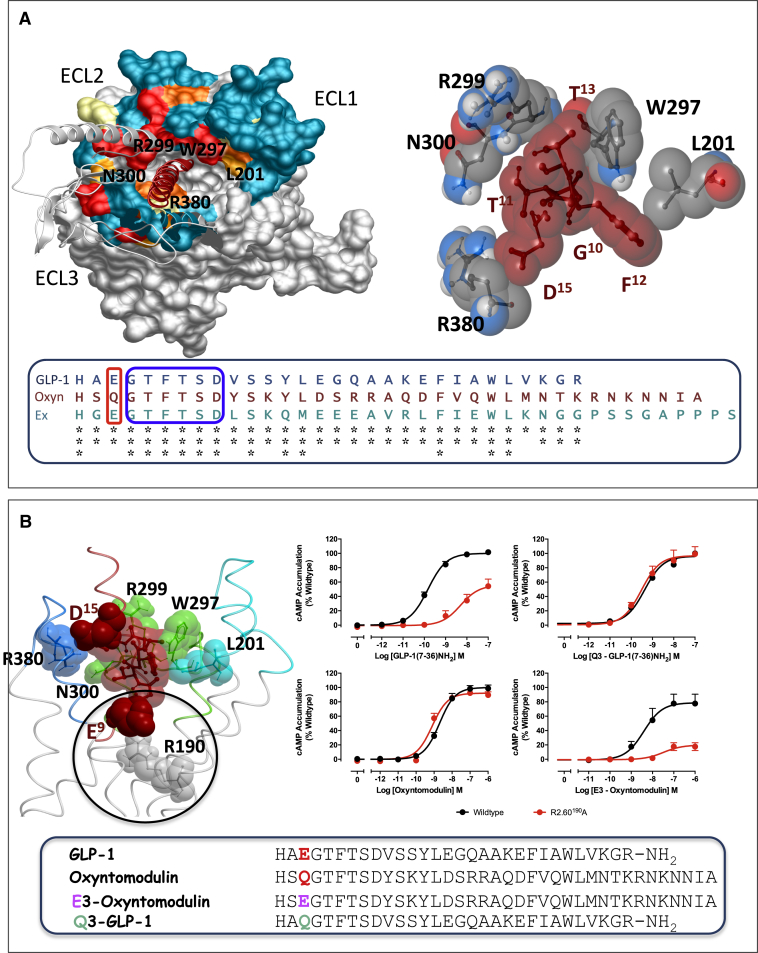
Direct Interactions of the GLP-1R ECL Residues and TM Bundle with GLP-1 Predicted from Molecular Modeling, Related to Figures 1 and 2(A) Top left: Molecular model of GLP-1 (maroon) docked to the GLP-1R with key ECL residues labeled that line the entry to a deep cavity where the N terminus of GLP-1 is predicted to bind. Colors are the heatmaps from binding studies of GLP-1 from Figure 2. Top right: Close up of the peptide and ECL GLP-1R side chains that form direct interactions. Bottom: Sequence alignment of GLP-1, oxyntomodulin (Oxyn) and exendin-4 (Ex) highlighting the absolute sequence conservation within the region of the GLP-1 peptide (blue box) that is predicted to interact with the ECL residues, L201, W297, R299, N300, and R380 in the molecular model. Within the extreme N terminus of the three peptides, only position 3 (position 9 in the unprocessed GLP-1 peptide) differ significantly between GLP-1 and exendin (E) in comparison to oxyntomodulin (Q), as highlight by the red box.(B) E9 of GLP-1 (position 3) is predicted to interact with R1902.60 within the TM bundle cavity. Q3 of oxyntomodulin would not be predicted to form this sat bridge. In support of this, mutation of R190 to A markedly reduced cAMP signaling by GLP-1 (top left graph) but not oxyntomodulin (bottom left graph). To further validate the peptide docking in the GLP-1R model, substitution of E9 with Q in the GLP-1 displayed a profile similar to that of oxyntomodulin at the R190A mutant receptor (top right graph). In contrast, substitution of Q3 in oxyntomodulin with E produced a peptide with a similar profile to GLP-1 at R190A, with attenuated cAMP production compared to the wild-type receptor (bottom right graph).